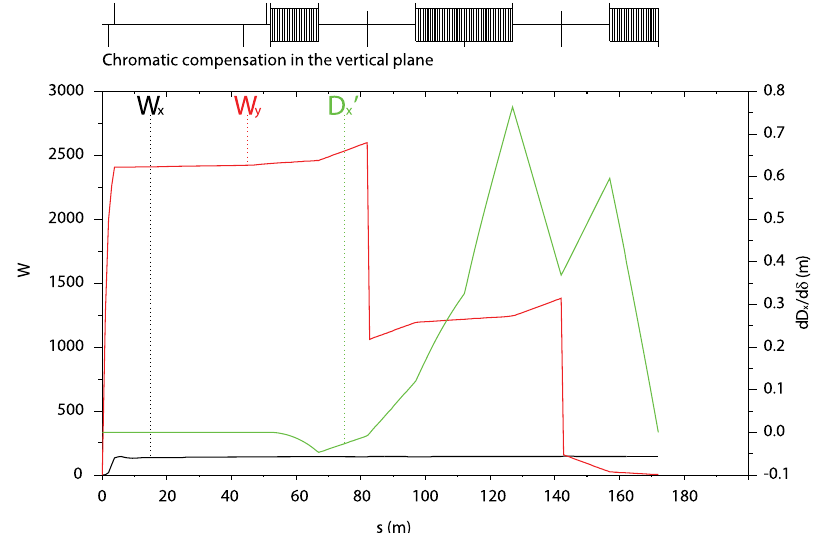
FIG. 9. W function and the second-order dispersion in the final focusing system with the local chromatic